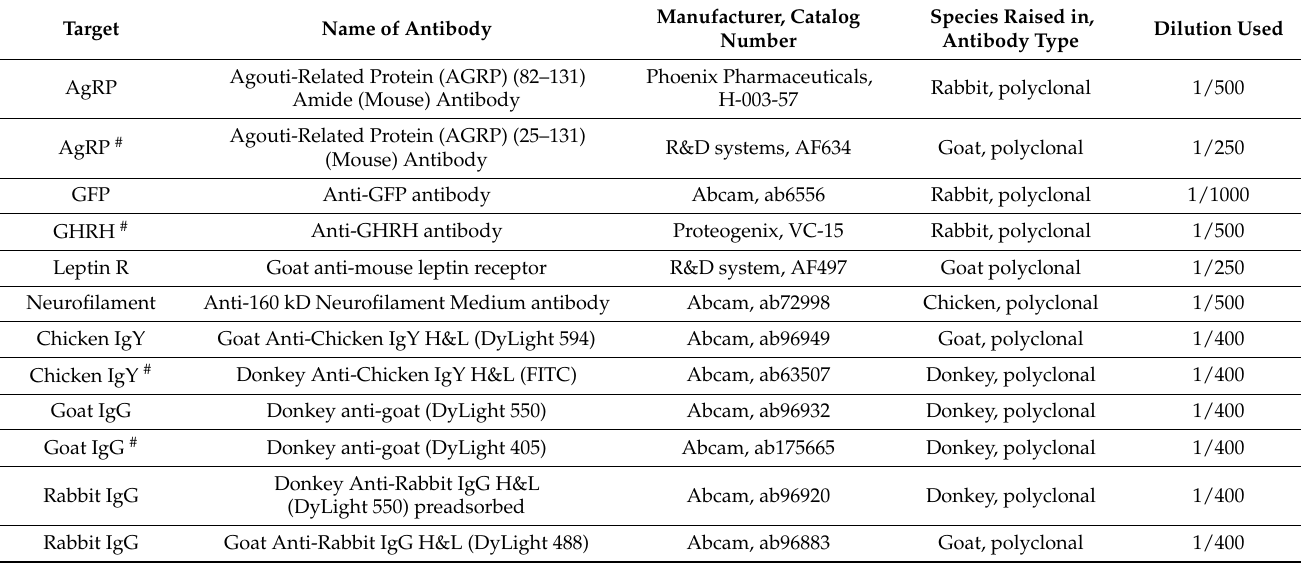
Table 1. Primary and secondary antibodies used for immunohistochemistry